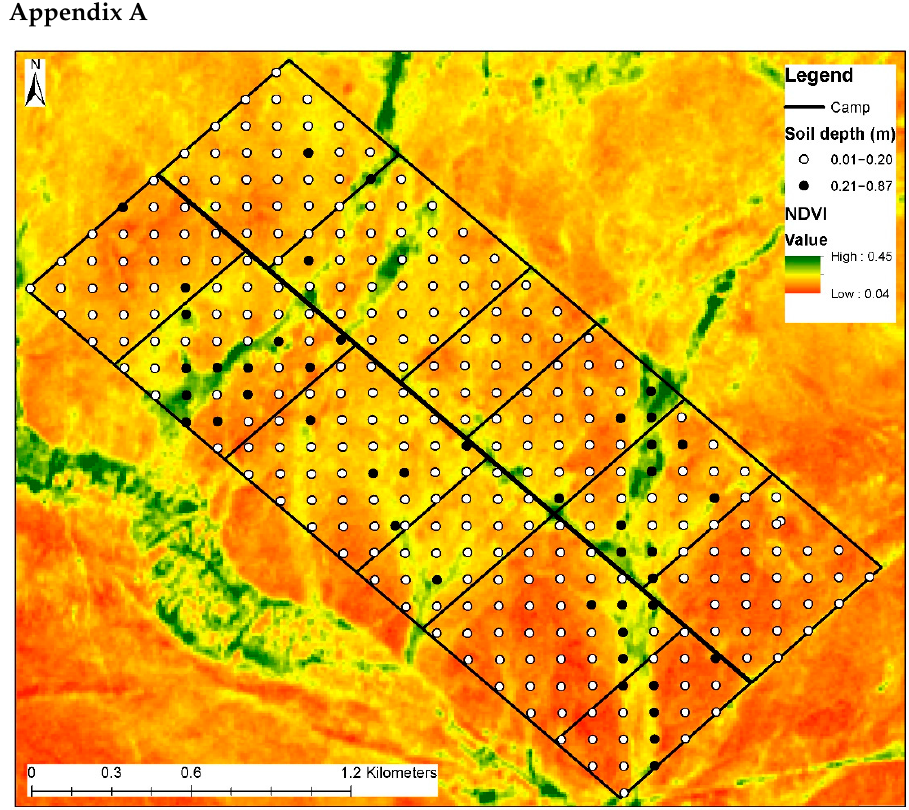
Figure A1. Soil depth classification and the average NDVI values across the camps of the stocking density trial area. The white circles show soil with a depth of 0.01 to 0.20 m and the black circles show soil with a depth of 0.21 to 0.87 m.